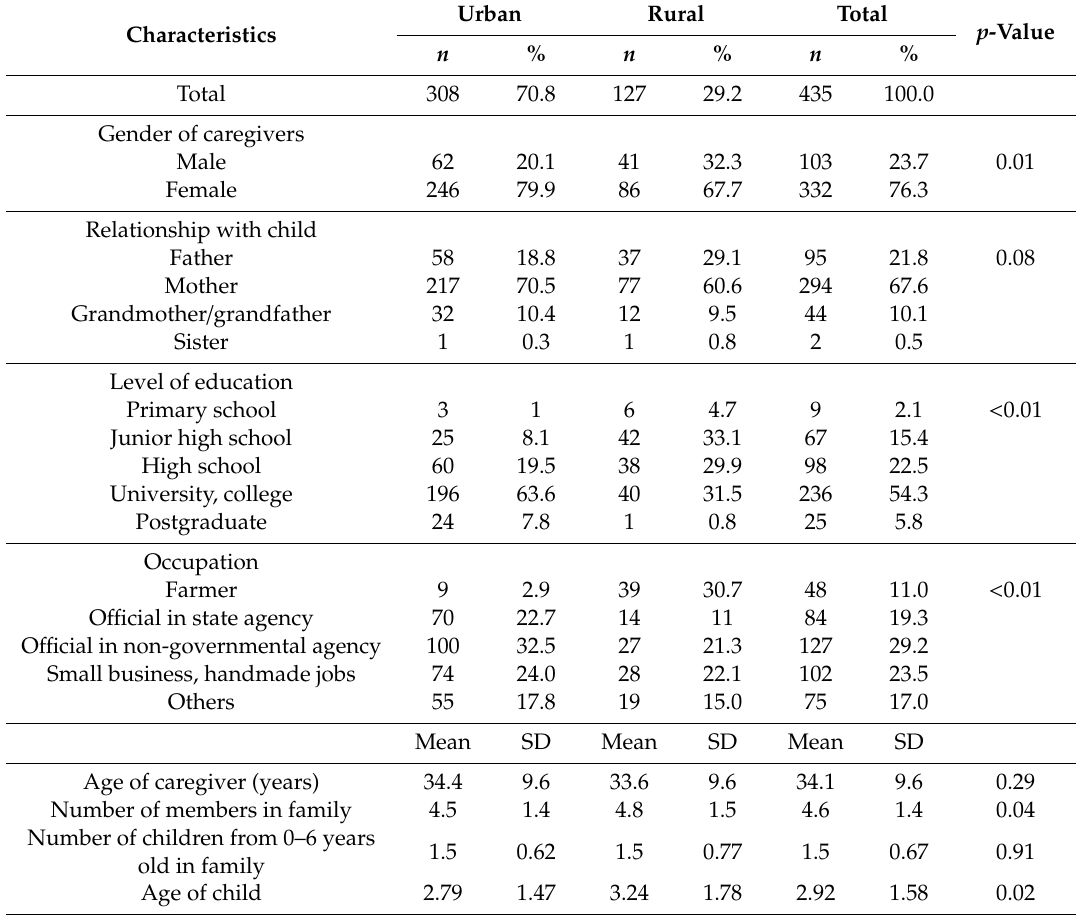
Table 1. Sociodemographic characteristics of